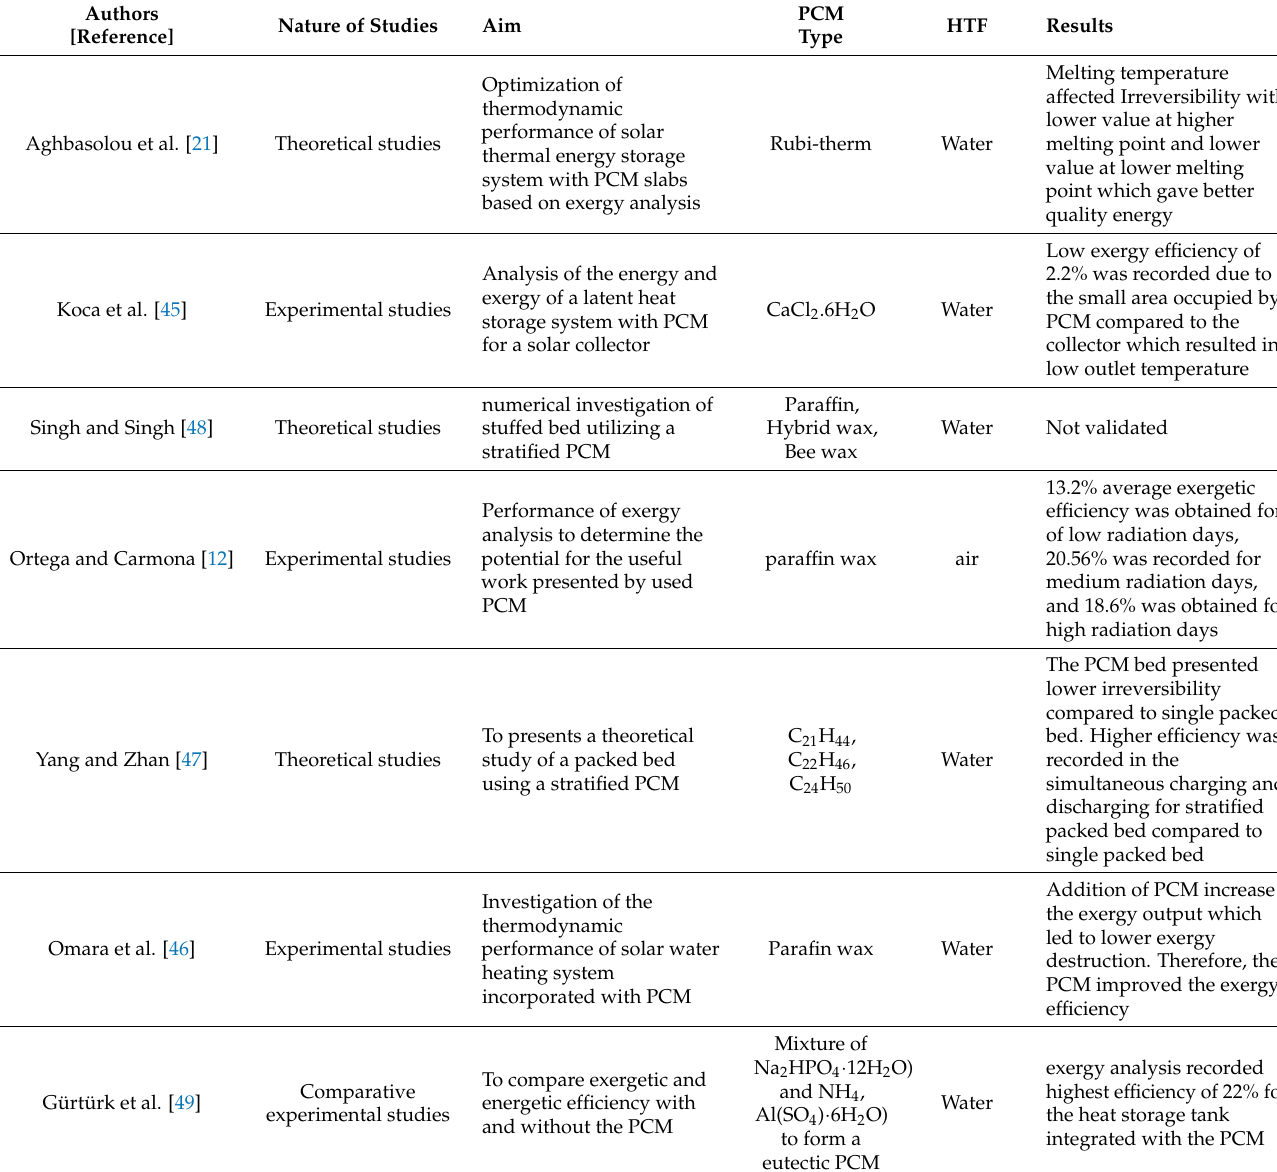
Table 1. Results of some of the studies presented on water heating and the PCM